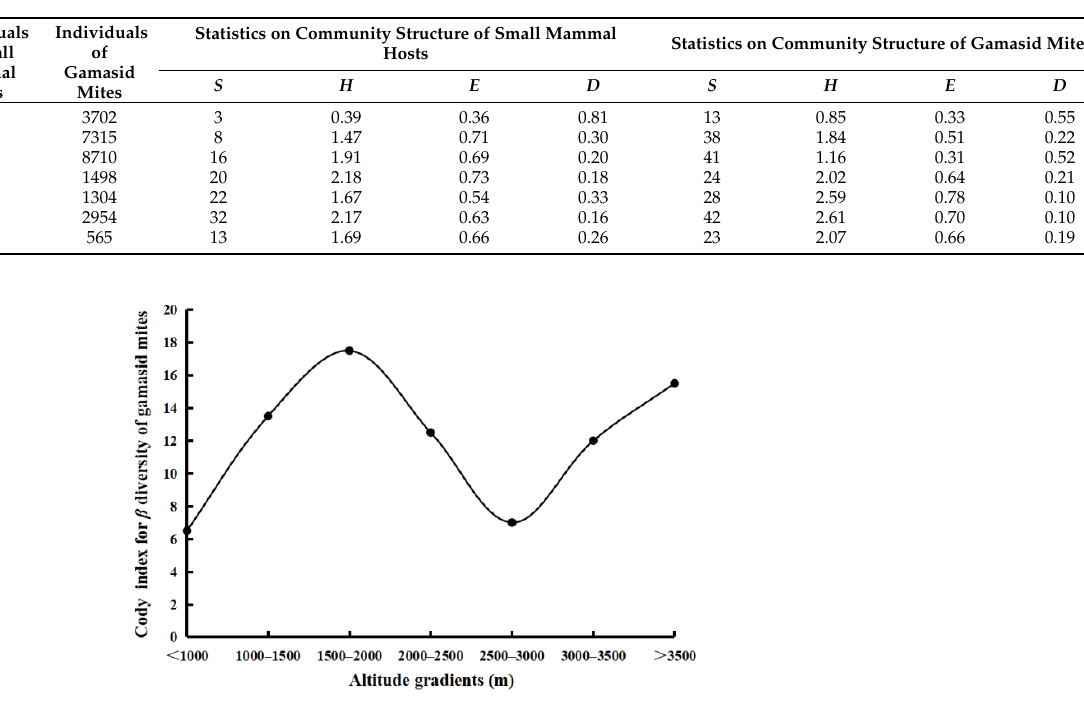
Figure 3. Variations of β diversity of gamasid mites along altitude gradients in Three Parallel Rivers Area in northwest Yunnan of China (2001 – 2015).